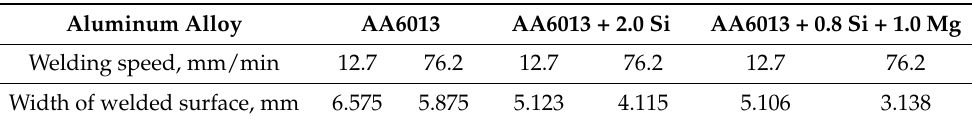
Table 3. Effect of chemical composition of aluminum alloys and welding speed on cross-sectional width of welded surface.